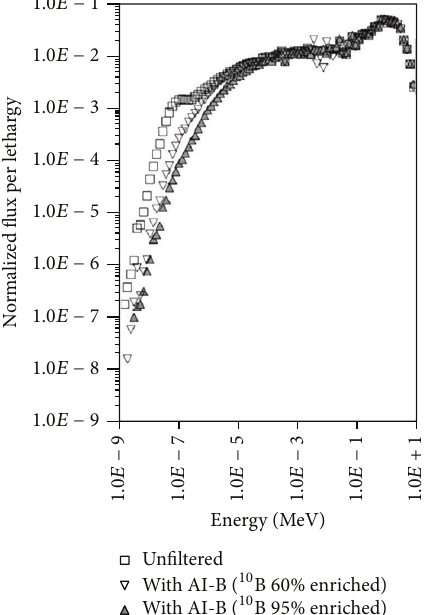
Figure21:Neutronspectrumcomparisonforthreecases:unfiltered, with Al-B ( 10 B 60% enrichment) filter, and with Al-B ( 10 B 95% enrichment) filter [8].